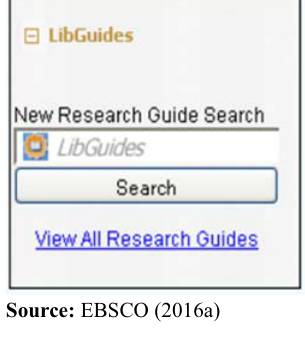
Figure 1. LibGuides